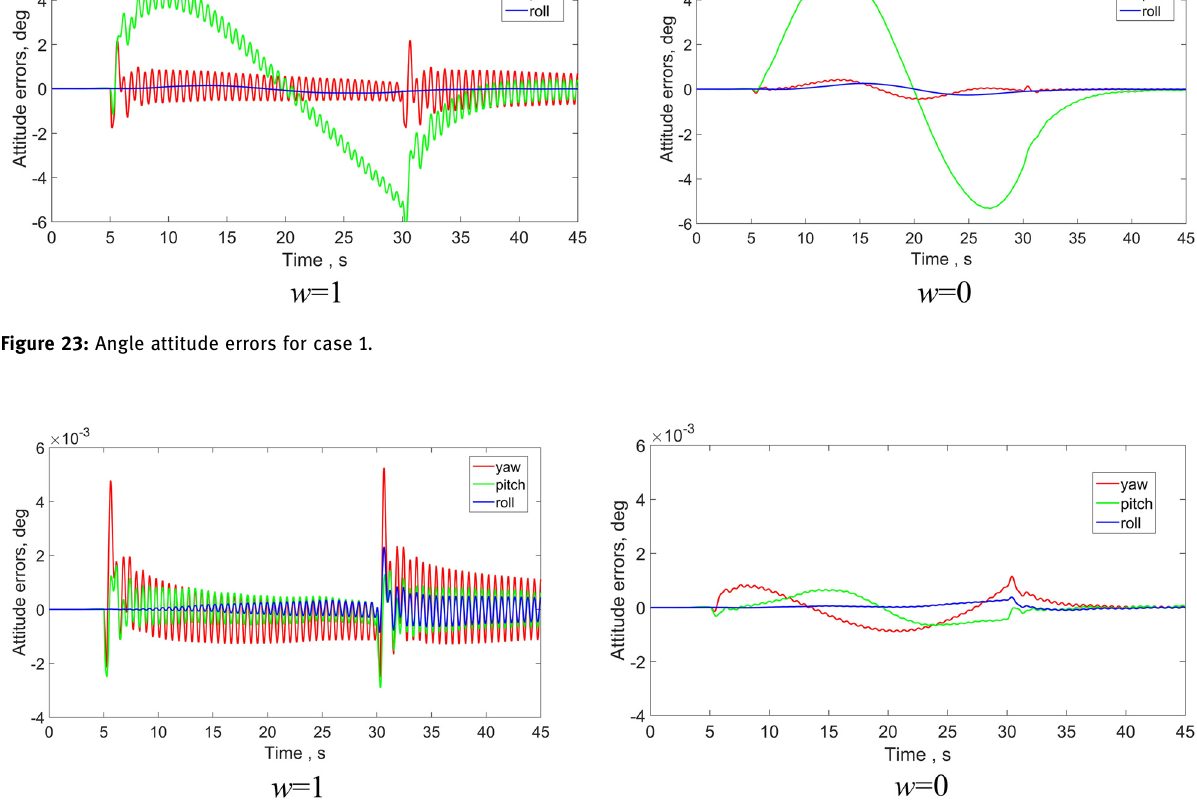
Figure 24: Angle attitude errors for case